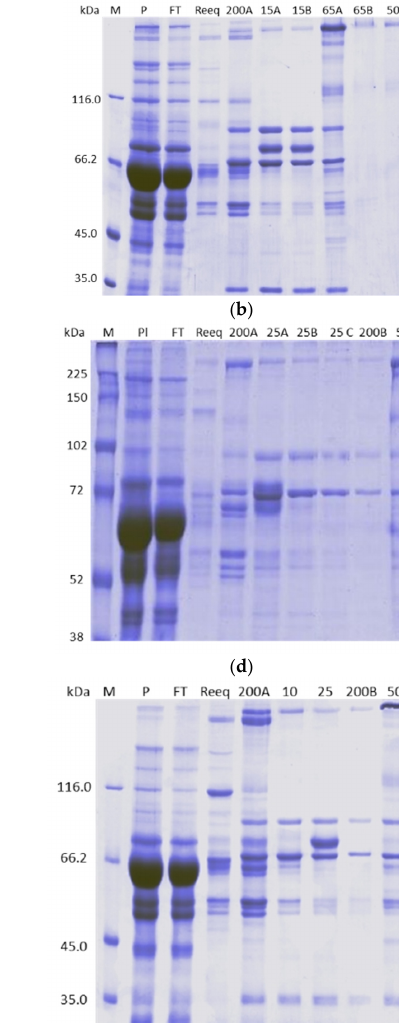
Figure 3. SDS ‐ PAGE (7.5%) analysis under reducing conditions of purification of plasma on: ( a ) Q Sepharose FF with 5 to 100 mM linear CaCl 2 gradient and citrate buffer; ( b ) Fractogel EMD TMAE with 5 to 50 mM linear CaCl 2 gradient and citrate buffer; ( c ) ANX Sepharose FF with 5 to 25 mM linear CaCl 2 gradient using citrate buffer; ( d ) DEAE Sepharose FF with 5 to 50 mM linear CaCl 2 gradient and citrate buffer; ( e ) Fractogel EMD DEAE with 5 to 50 mM linear CaCl 2 gradient and citrate buffer; ( f ) ANX Sepharose FF with 5 to 25 mM linear CaCl 2 gradient and Bis ‐ tris buffer; and